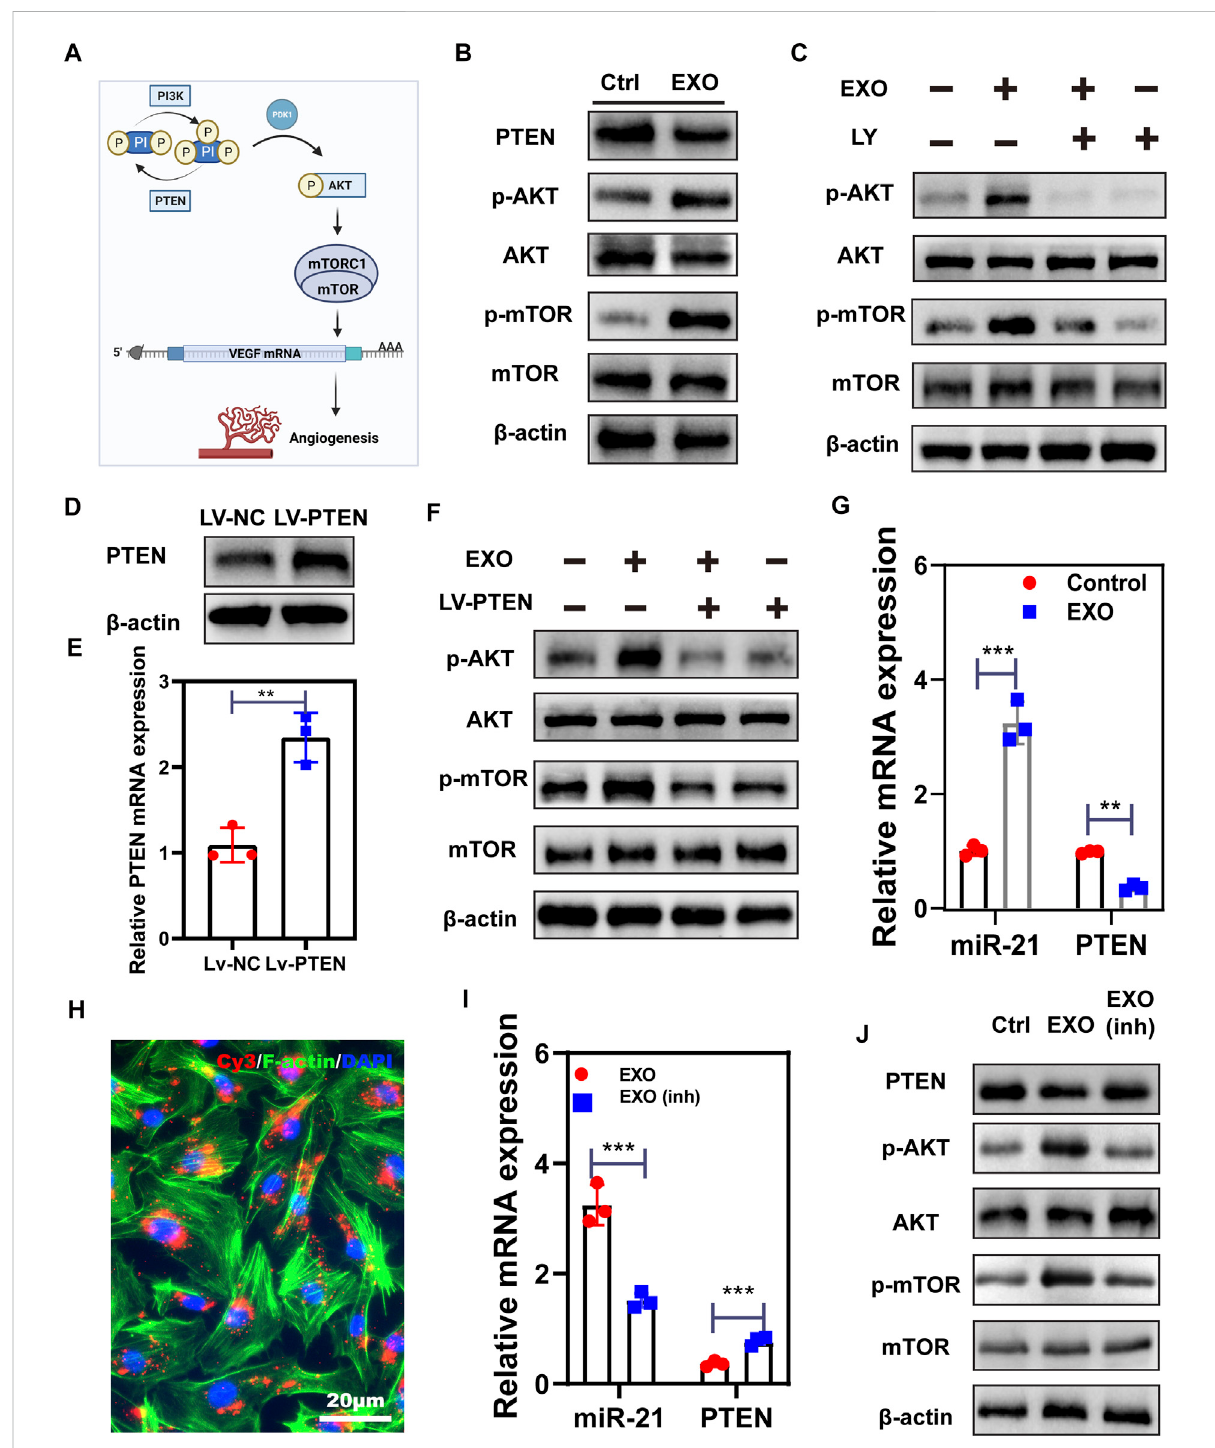
FIGURE 4 M2-EXOactivatesAKT/mTORsignaling bytargetingPETNthroughmiR-21. (A) TheschematicofangiogenesisworkingthroughthePTEN/AKT/mTOR axis.CreatedwithBioRender.com. (B) WesternblotwasusedtotestthephosphorylationofPTEN,AKTandmTORinducedbyM2-EXO. (C) Westernblotwas usedtotestthecounteractionroleofpathwayinhibitorLYonphosphorylationofAKTandmTORinducedbyM2-EXO. (D,E) qRT-PCRandWesternblotwere used to verify the overexpression of PTEN (F) The overexpression of PTEN counteracted the phosphorylation promotion of AKT and the mTOR axis induced by M2-EXO. (G) qRT-PCR was used to test miR-21 and PTEN expression levels after M2-EXO treatment. M2-EXO reduced PTEN expression while increasedmiR-21expression. (H) FlorescenceofCy3-miR21-M2-EXOtransportationinto HUVECcells, showingvehiclefromM2-EXOto HUVECs; (I) qRT- PCRwasusedtotestmiR-21andPTENexpressionlevelsafterM2-EXOandM2-EXO-miR-21-inhibitortreatment.M2-EXO-inhcounteractedthefunctionof M2-EXO. (J) WesternblotwasusedtotestPTENandAKTandmTORphosphorylationafterM2-EXOinhtreatment.Datawasexpressedasmean±3 σ ( n =3); * = signi fi cant, * p < 0.05; ** p < 0.01,*** p < 0.005; **** p < 0.001, Student t